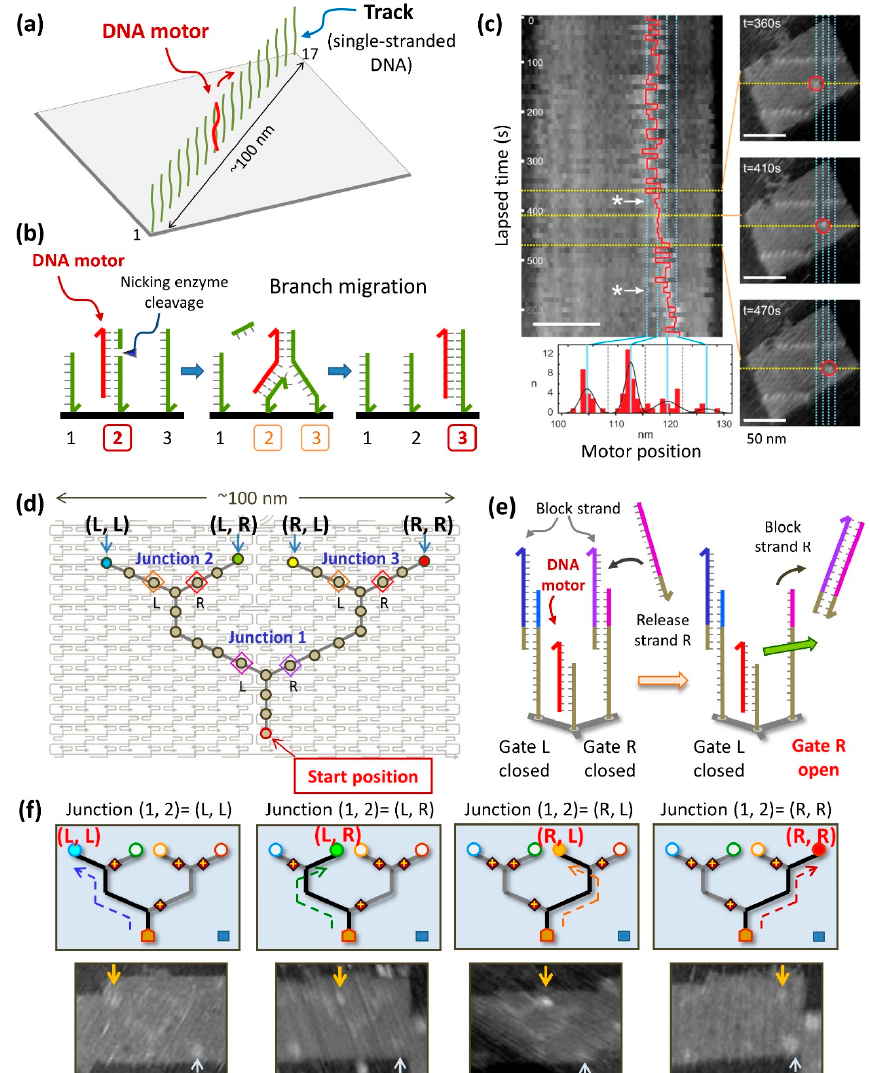
Figure 3. A DNA motor system constructed in the DNA origami structure [20]. ( a ) A track consisting of 17 ssNAs (green) constructed on a DNA origami structure. The DNA motor strand (red) moves on the track in one direction using enzymatic reaction. ( b ) Mechanism of DNA motor system using branch migration. After cleavage of nicking enzyme, the DNA motor hybridized to the ssDNA (green) in the track moves to the adjacent DNA strand with the same sequence via intermediate state (branch migration). ( c ) Single-molecule visualization of the DNA motor using high-speed AFM and its analysis. The DNA motor moved stepwise along the ssDNAs in the track, and the intermediate state of the branch migration could also be visualized. ( d ) A DNA motor system using a branched track and controllable gates [21]. A track consisting of ssDNAs having three branch points (junctions) and four end points constructed on the DNA origami structure. The DNA motor moves along the ssDNAs in the branched track from the start position. ( e ) The control of opening the gates constructed on both sides of the branch point by strand displacement. ( f ) The branched track controlled by multiple gates and the programmed movement of the DNA motor by following the instructions. AFM images of the DNA motor movement directed by the designed